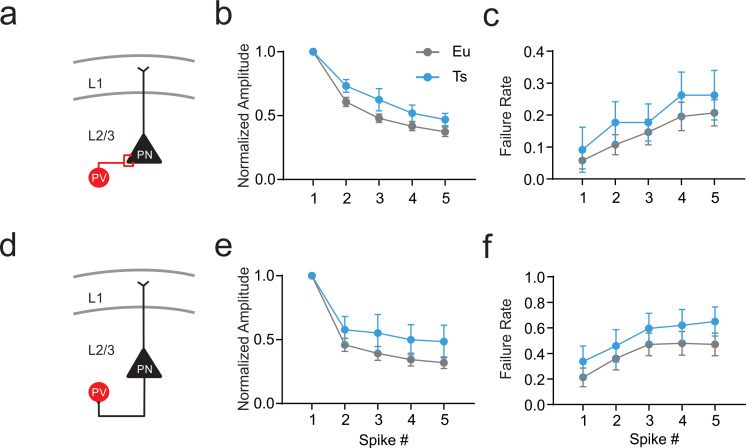
Short term plasticity of the perisomatic inhibitory loop in Ts.(a) Schematic representation of the inhibitory synapse of the cortical dendritic inhibitory loop mediated by MCs. (b) Normalized amplitude of IPSCs evoked by a 5-AP train applied at 50 Hz to the presynaptic MC (Two-Way ANOVA genotype factor: F(1,32)=3.127, p=0.0865). (c) Failure rate of synaptic responses evoked by each AP of the train (Two-Way ANOVA genotype factor: F(1,32)=0.5324, p=0.4709, n = 26 and 8 pairs for Eu and Ts, respectively). (d) Schematic representation of the excitatory synapse between PN and MCs. (e) Normalized amplitude of EPSCs evoked by a 5-AP train applied at 50 Hz to the presynaptic PN (Two-Way ANOVA genotype factor: F(1,22)=2.022, p=0.1755). (f) Failure rate of synaptic responses evoked by each AP of the train (Two-Way ANOVA genotype factor: F (1,22)=0.7742, p=0.3928, n = 15 and 9 pairs for Eu and Ts, respectively).Figure 3—figure supplement 1—source data 1.Short term plasticity of the perisomatic inhibitory loop in Ts.